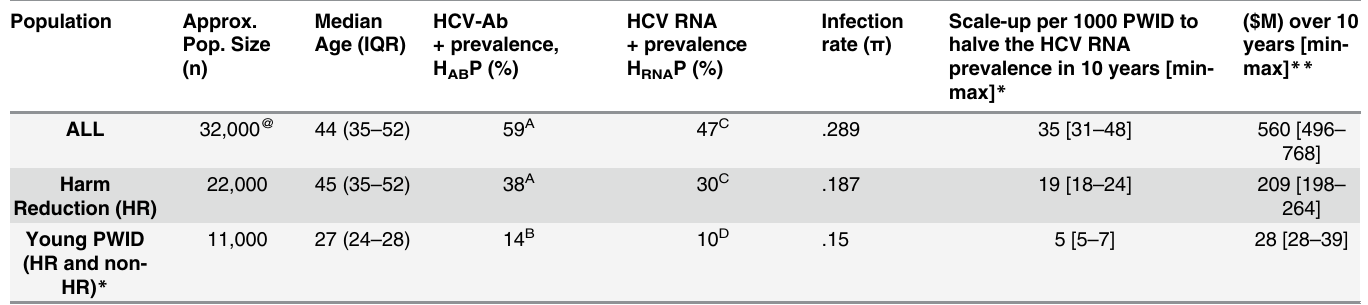
Table 2. Prevalence and treatment scale-up